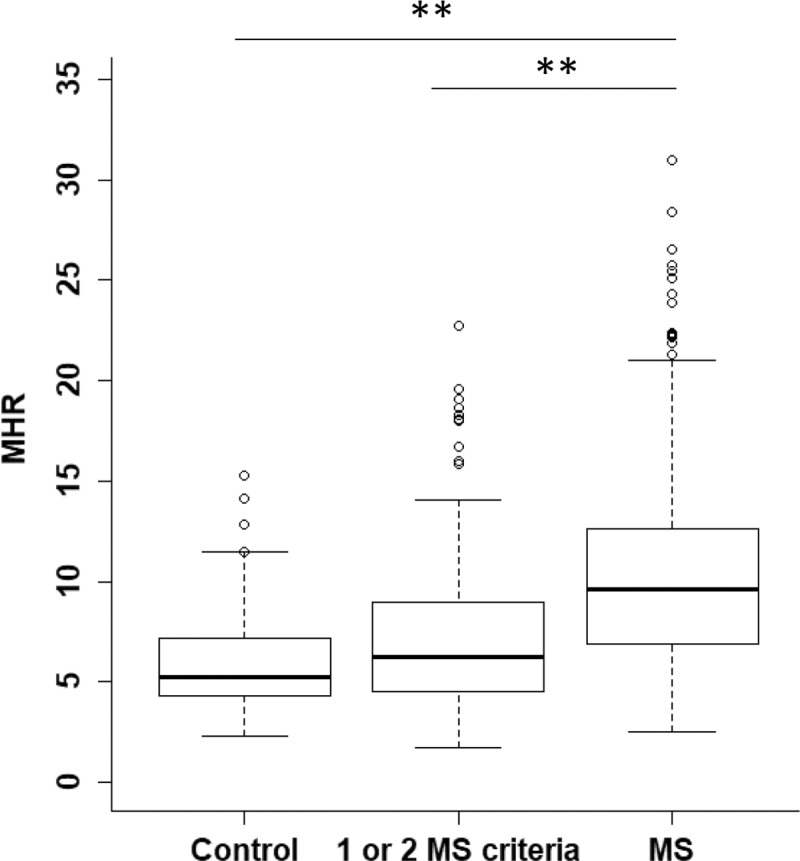
Correlation of monocyte to HDL ratio (MHR) with MS criteria.Box-plot showing the distribution of MHR values in control, patients with 1 or 2 MS criteria and MS patients. The horizontal lines represent the limits of quartiles, whereas the thicker central one indicates the median. Dots above the upper limits shows outliers. ANOVA test detected a significant difference among groups (p-value<0.001) ** p-value<0.001 for Tukey post-hoc test.